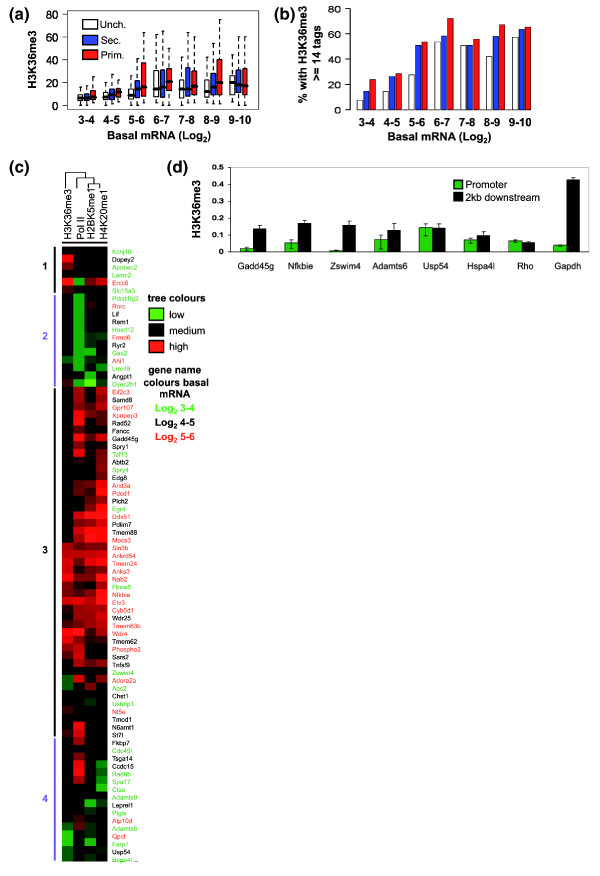
Inducible genes have higher levels of the elongation mark H3K36me3. (a) Data from ChIP-Seq experiments on human CD4+ lymphocytes were used to determine the levels of H3K36me3 within the gene (+6 to +8 kb) for primary (red), secondary (blue) and unchanged (white) genes in each basal expression bin (Log2 robust multichip average values from expression profiling). The bar marks the median score, the edges of the boxes the second and third interquartile ranges and the whiskers the first and fourth interquartile ranges. (b) The genes with tag counts equal to or greater than the median level (14) for the unchanged genes in the basal expression Log2 6 to 7 bin were considered to have H3K36me3, and the percentage of genes that were H3K36me3 positive for each subgroup is shown. (c) From the same data source the number of sequencing tags for Pol II (-0.25 kb to +0.25 kb) and the putative elongation marks H2BK5me1 (0 to +2 kb) and H4K20me1 (0 to +7.5 kb) as well as H3K36me3 were counted for genes with basal expression values between Log2 3 and 6. The logs of the sequence counts were median centered and normalized and heatmaps for the primary response genes were generated by uncentered correlation, complete linkage clustering. The major clusters are marked and the genes are colored according to their basal expression level (green, log2 3 to 4; black, log2 4 to; red, log2 5 to 6). In the cluster diagram green indicates low tag counts and red indicates high tag counts. (d) ChIP assays were performed with antibodies against trimethylated H3K36 (H3K36me3) using unstimulated EL-4 T cells and detected by real-time PCR analysis. The data are presented as the ratio of immunoprecipitated DNA to the total input DNA and shows H3K36me3 occupancy at the promoter (green bars) and 2 kb downstream of the promoter (black bars). The mean and standard error of three independent experiments are shown.